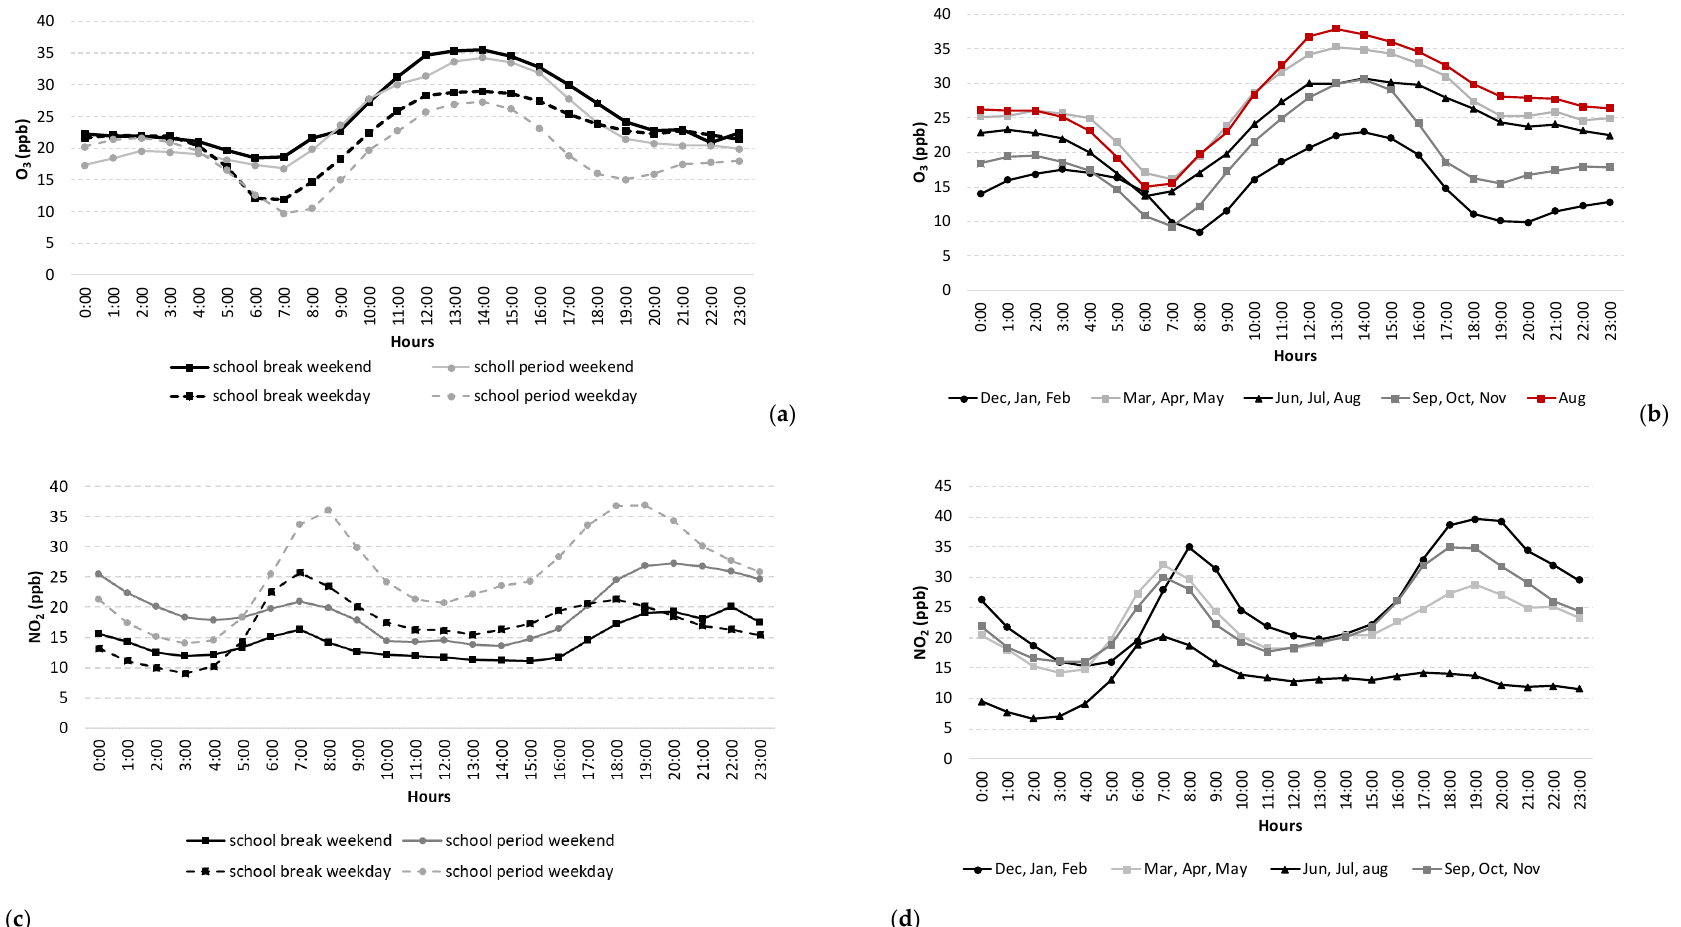
Figure 6. ( a ): Ground-level ozone on an average day for each school season (weekday and weekend); ( b ): seasonal ground-level ozone concentration hot spot; ( c ): ground level NO 2 concentration on an average day for each school season (weekday and weekend); ( d ): seasonal NO 2 concentration.